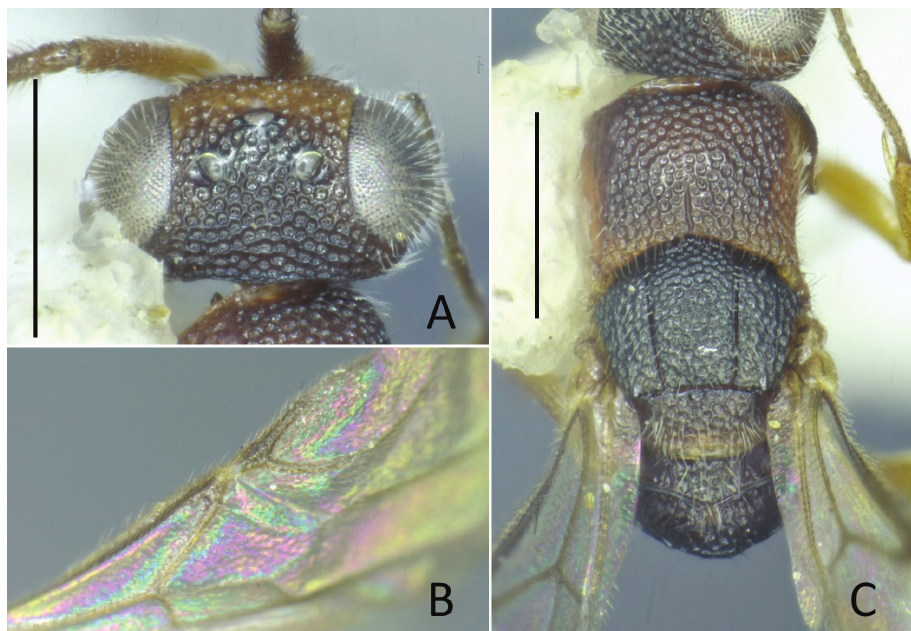
Figure 4. Baeosega humida Krombein, allotype ♂ A head in dorsal view B forewing C mesosoma. Scale bars: 0.5